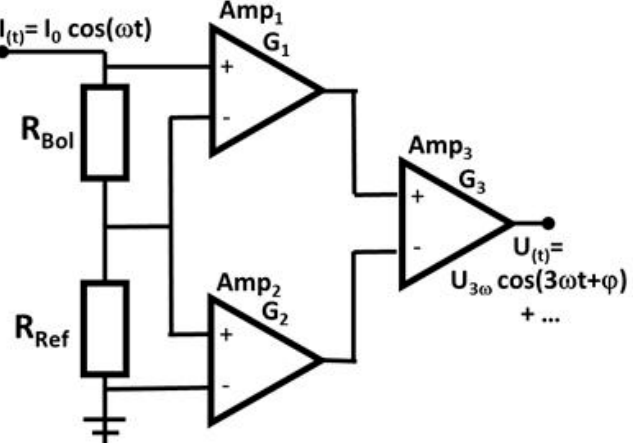
Figure 1. Example for an evaluation circuit for the 3 ω voltage that is caused by the temperature modulation of a bolometer structure R Bol that is driven by an AC current wit frequency ω . A reference resistor R Ref is driven by the same AC current but without temperature modulation. The two resistor voltages are subtracted after an amplification with a matched gain ratio G 1 /G 2 = R Ref /R Bol , obtaining an 3 ω -signal with high signal to noise